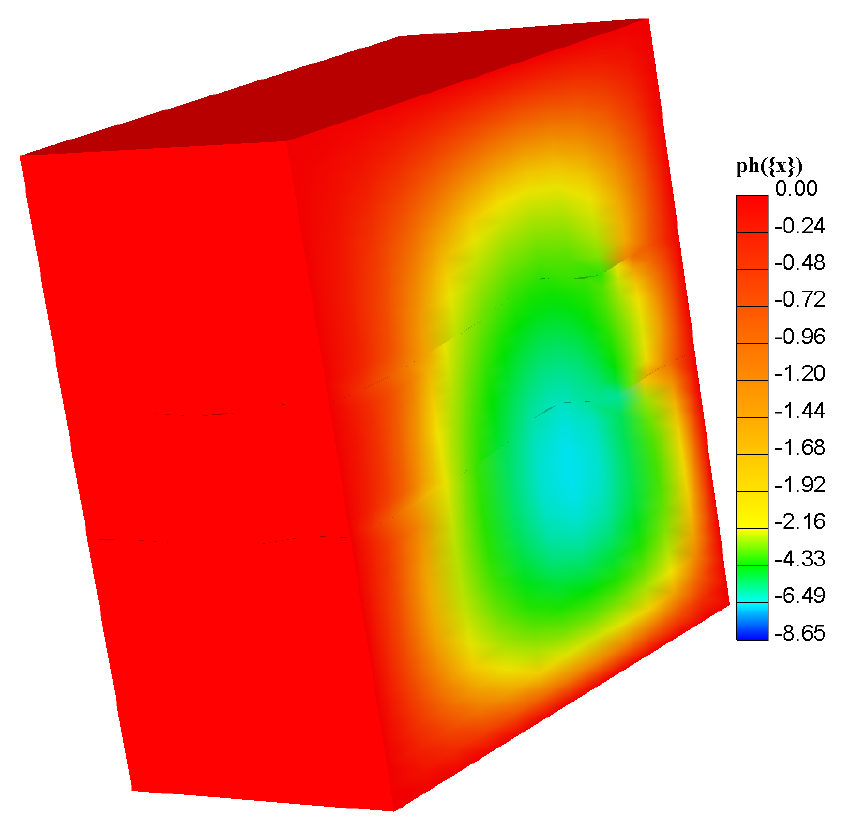
Figure 9. SPP (saddle-point problem) solution to Example 1 in Section